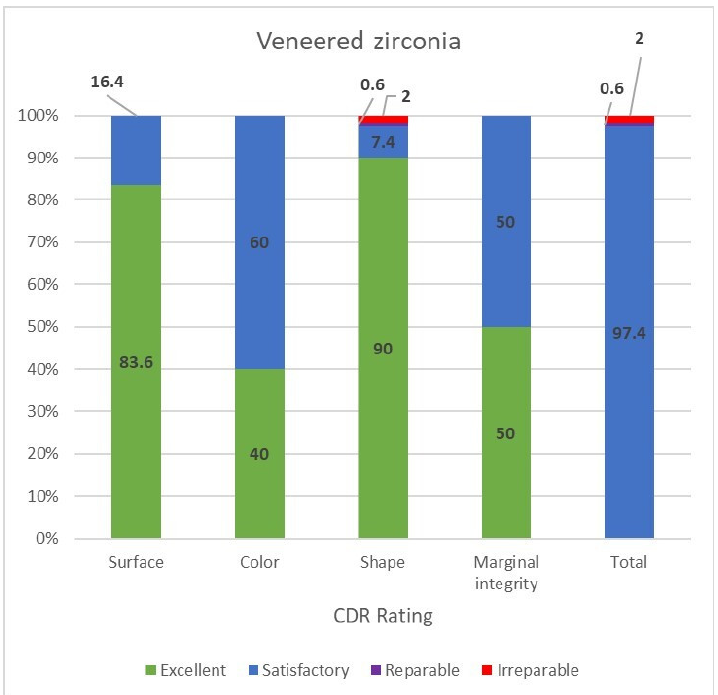
Figure 7. CDA ratings for the veneered zirconia group.